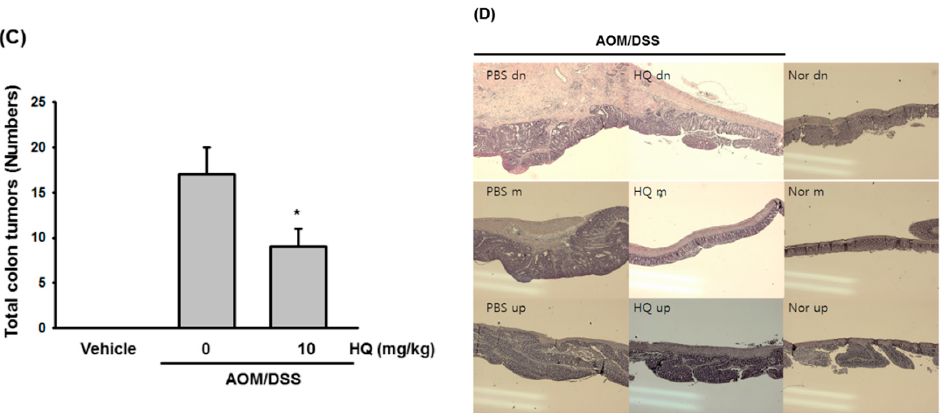
Figure 6. Effect of HQ on the generation of AOM/DSS-induced colon cancer in mice. ( A ) Schematic diagram of in vivo colitis-associated colon cancer model. ( B ) AOM/DSS-induced colon cancer mice were treated with either vehicle or HQ (10 mg/kg) twice a week for 4 weeks. After euthanasia, the colons excised from AOM/DSS-induced colon cancer mice were photographed and compared with that from normal mice treated with vehicle. ( C ) The total number of tumors generated in the colons of the mice were counted and plotted. ( D ) The three parts of the colons excised from these mice were stained with hematoxylin and eosin. dn, distal colon; m, middle colon; up, proximal colon. * p < 0.05 compared to the control.